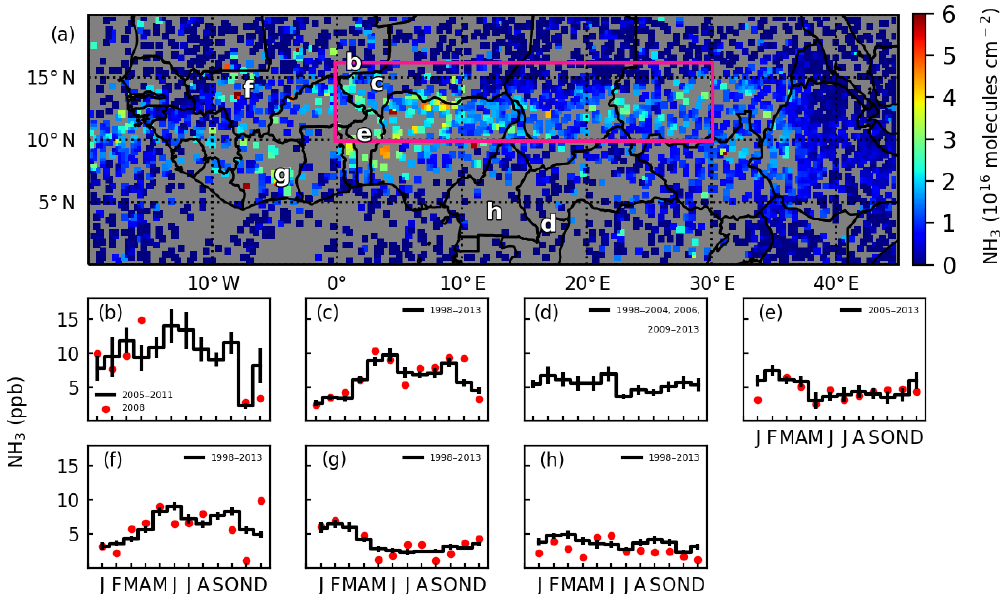
Figure 3. NH 3 pulsing over the Sahel in April and geographic variation in the seasonality of surface NH 3 concentrations over north equatorial Africa. (a) Observations by IASI during 25 to 28 April 2008 reveal elevated mean atmospheric NH 3 concentrations specifically over the Sahel region. (b–h) Monthly NH 3 gas concentrations from sites in the INDAAF network; black lines represent the multiyear mean and standard error for each site, and red dots represent the 2008 value. Data are presented for Agoufou, Mali (b) , Banizoumbou, Niger (c) , Bomassa, Congo (d) , Djougou, Benin (e) , Katibougou, Mali (f) , Lamto, Côte d’Ivoire (g) , and Zoétélé, Cameroon (h)